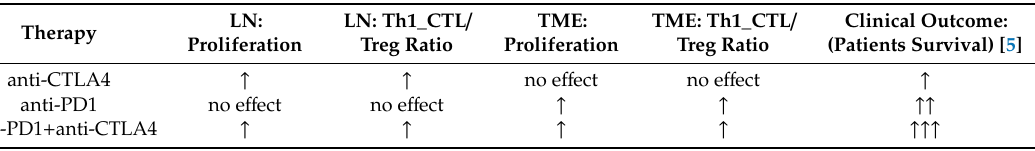
Table 3. Results from the logical model simulations of T cell response following di ff erent types of immune checkpoint inhibitors (ICI) therapy in the lymph nodes and in the tumour microenvironment. ( ↑ corresponds to upregulation and ↓ corresponds to downregulation of phenotype after ICI treatment. The intensity of the response is such that: ↑↑↑ > ↑↑ > ↑ ). The last column shows the reported e ffi cacy of treatments in a clinical study